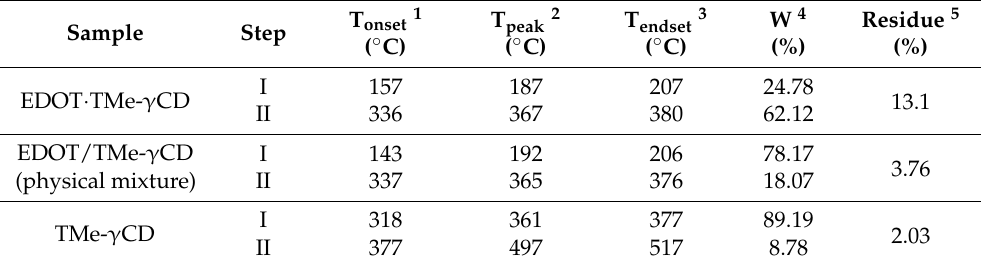
Table 2. Thermogravimetric data of EDOT · TMe- β CD, physical mixture, and TMe- β